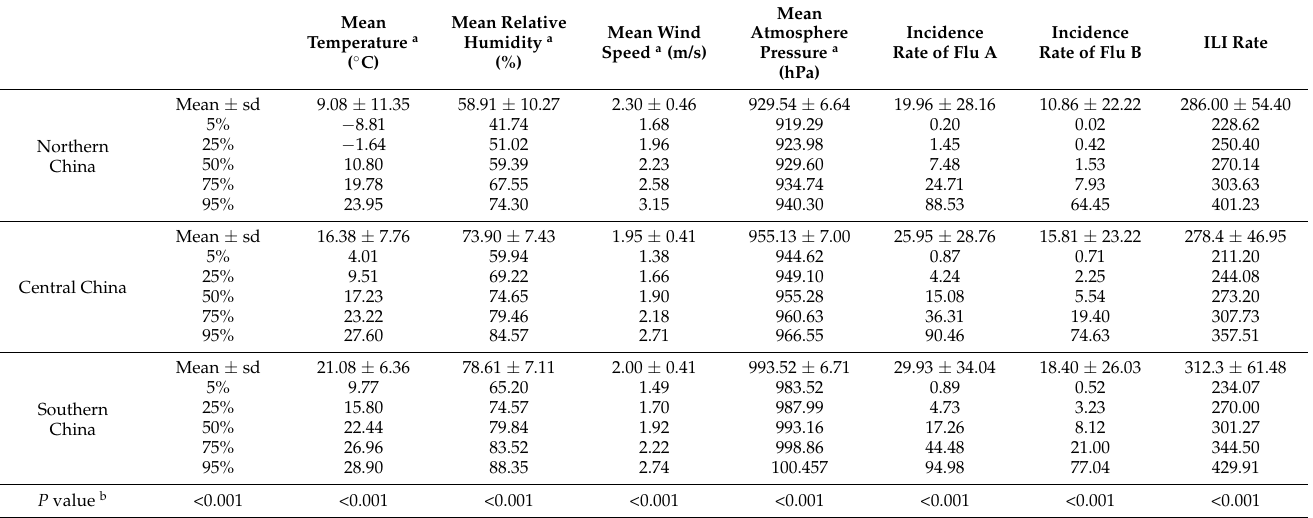
Table 1. Descriptive summary of meteorological variables and influenza rates in different regions.